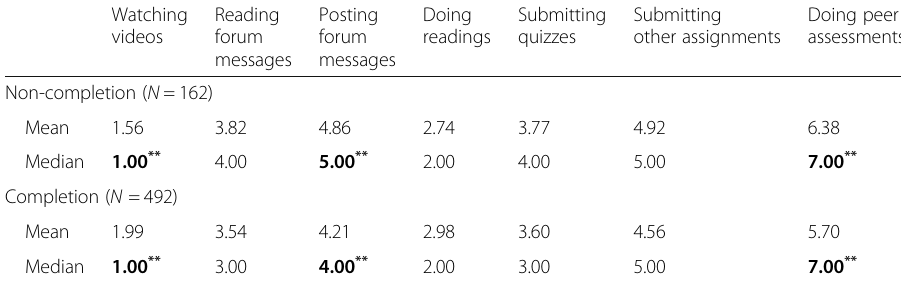
Table 3 Descriptive statistics on the rank of activity